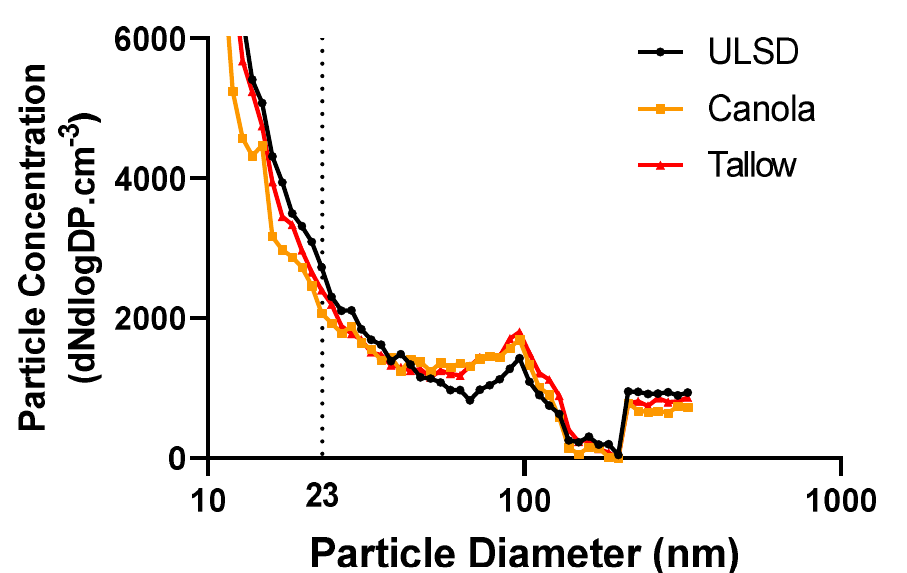
Figure 1. Particle size spectra representative of what each group of mice were exposed to for the three measured exhausts. Data were analyzed using total particle number concentration between the size of 10 and 340 nm for each fuel. Dotted line at 23 nm represents the approximate divide between solid and liquid particle formation [61]. No significant differences in particle number were found.